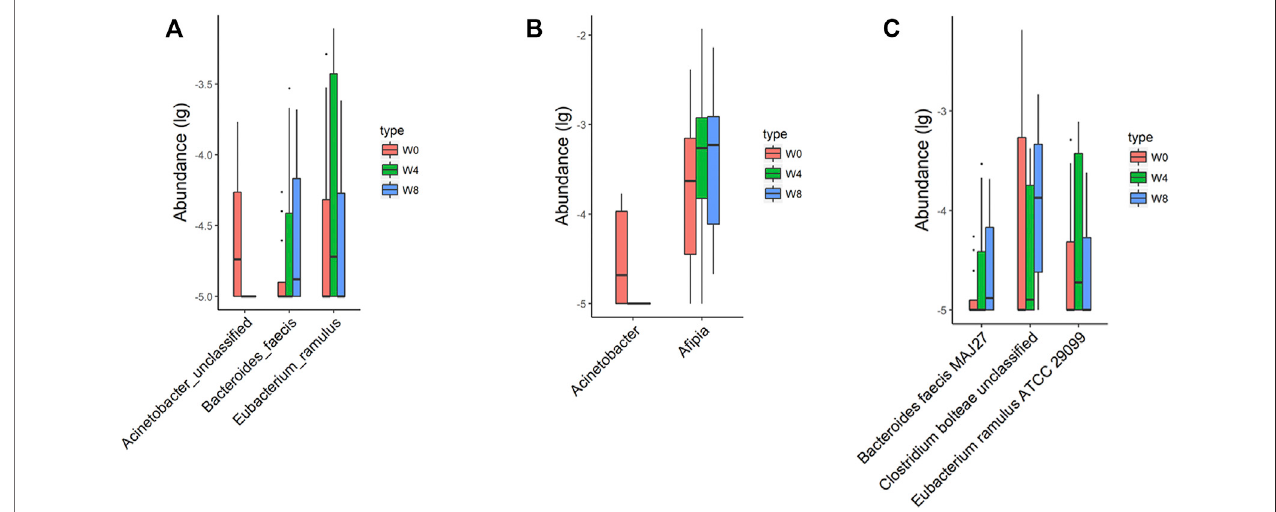
FIGURE 5 | Signi fi cantly different taxa at levels of species (A) , genus (B) , and strain (C) in comparisons between W0 vs W4, W0 vs W8, and W4 vs